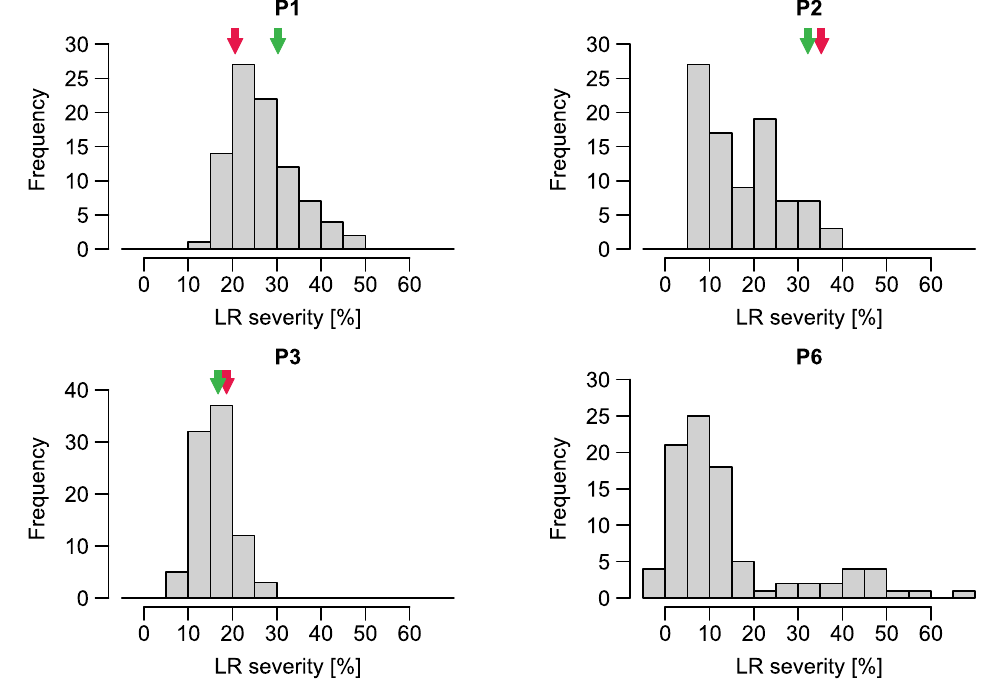
Figure 8. Histograms for populations P1–P3, P6 and P2TC for leaf rust. The red and green arrows indicate the value of the (stem rust) susceptible and resistant parent respectively; if not presented, it was no tested in the